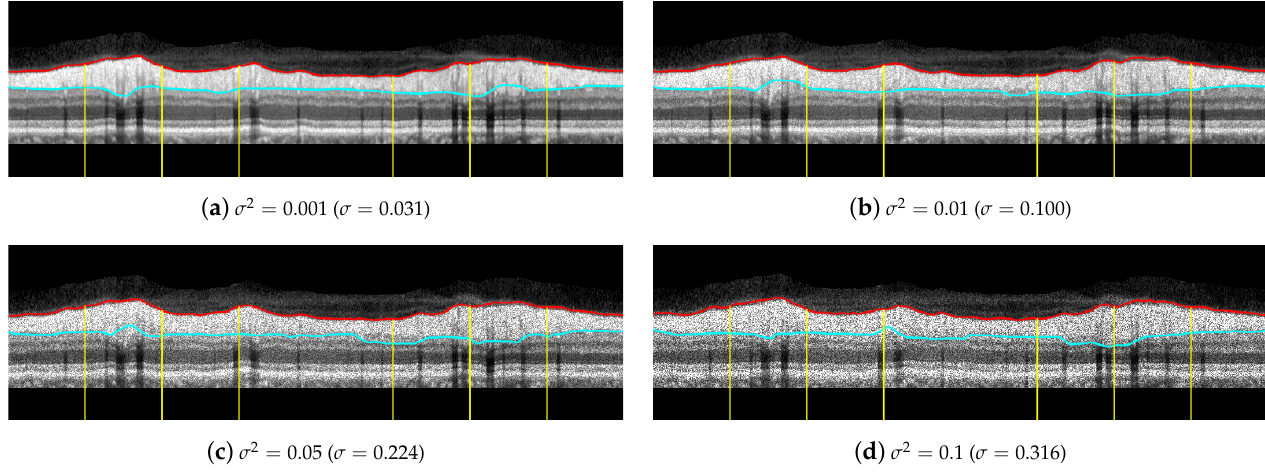
Figure 18. Results of testing the robustness against synthetically incorporated speckle noise from σ 2 = 0.001 to σ 2 = 0.1 ( σ = 0.031 to σ = 0.316). The NOLSE estimation [71] of the speckle noise for the raw image is σ 2 = 0.0000381 ( σ =